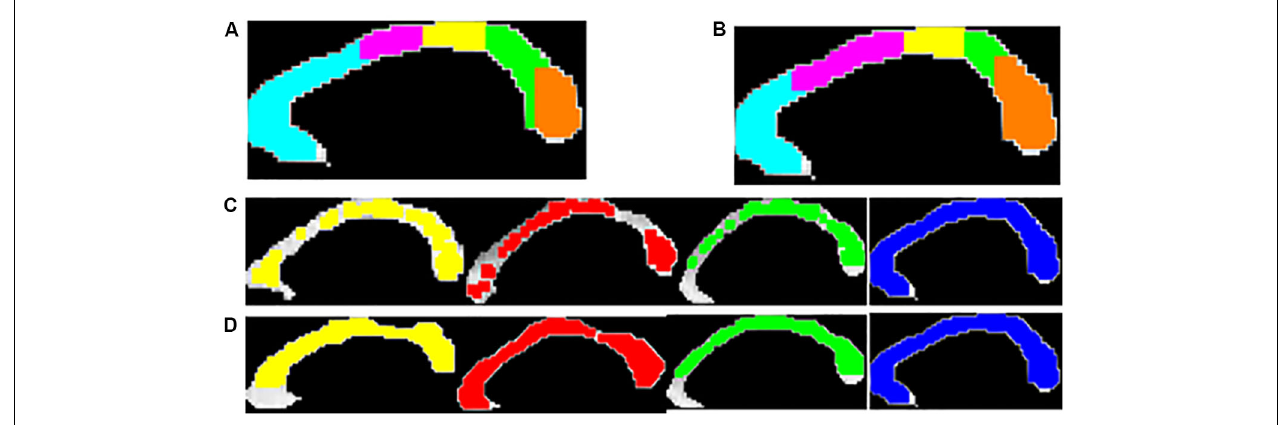
FIGURE 4 | Five anatomical sub-regions of CC using Witelson’s (A) and Hofer-Frahm (B) scheme is shown. Visualization of the local texture alteration using Energy (C) and Entropy (D) is shown for one representative subject of PD-NC (yellow), MSA (red), PSP (green) and HC (blue). The colored region showed the ROIs that were correctly classified based on LBP texture features.